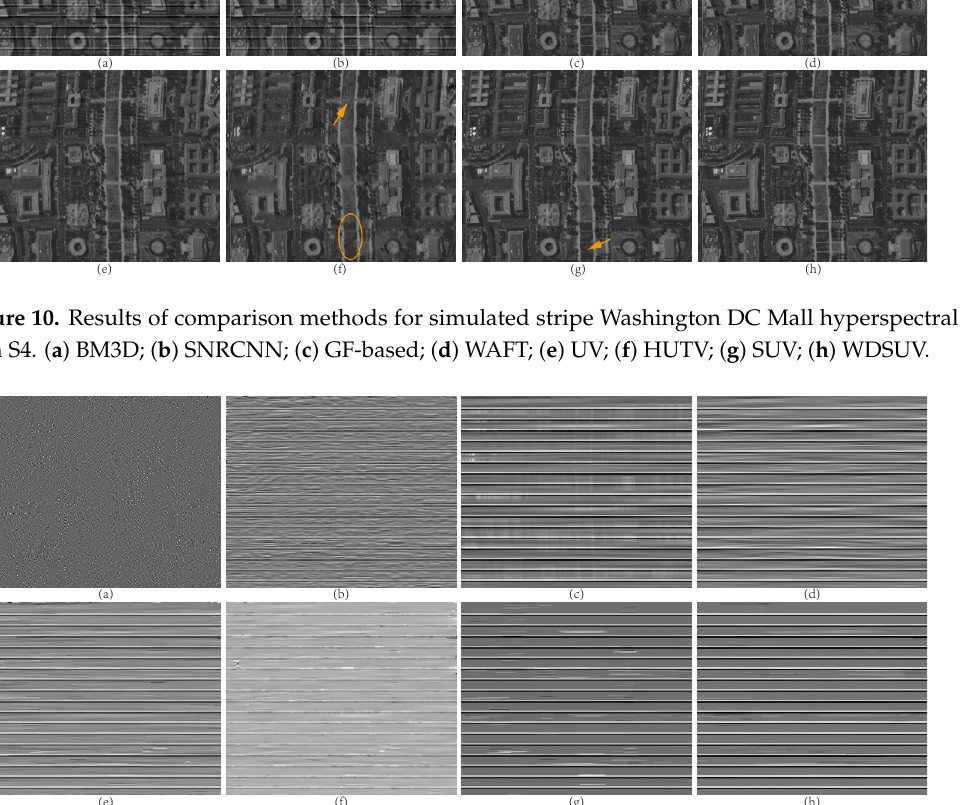
Figure 11. Noise estimation comparison results for simulated stripe Washington DC Mall hyperspectral data S4. ( a ) BM3D; ( b ) SNRCNN; ( c ) GF-based; ( d ) WAFT; ( e ) UV; ( f ) HUTV; ( g ) SUV; ( h )